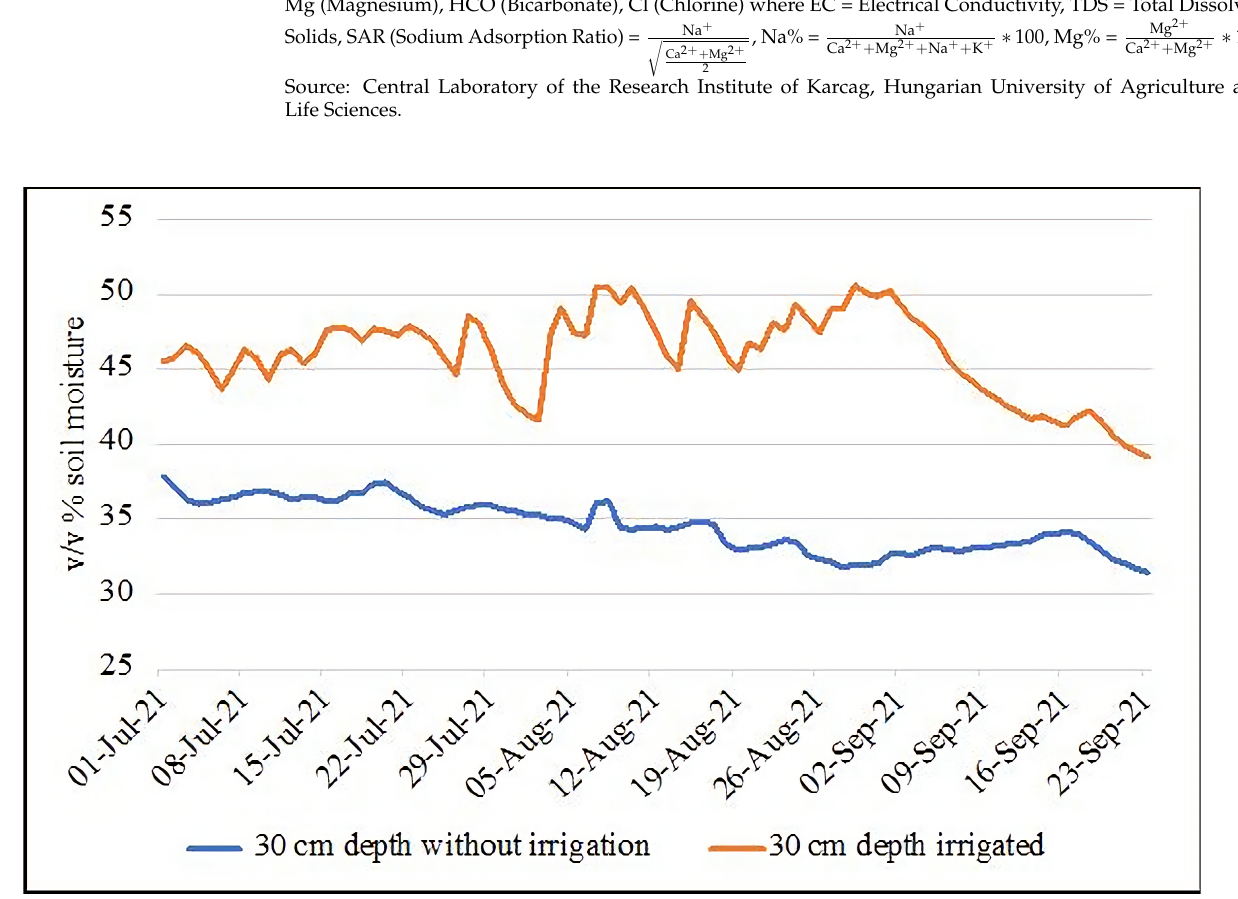
Figure 1. Soil moisture content in the important phenological stages during the growing season under irrigated and non-irrigated conditions. under irrigated and non-irrigated